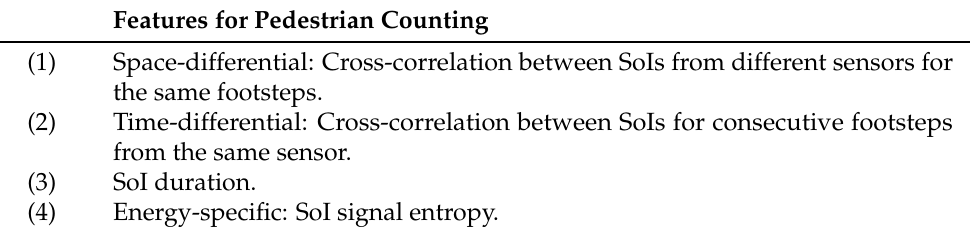
Table 1. Feature selection of previous work [15]. The features capture the information in vibration signals for footstep events from different